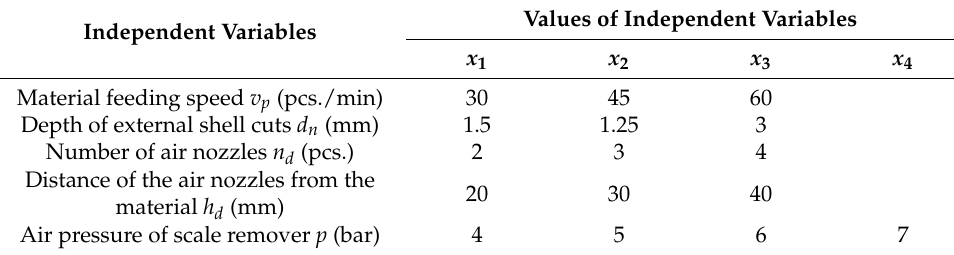
Table 1. Values of independent variables.